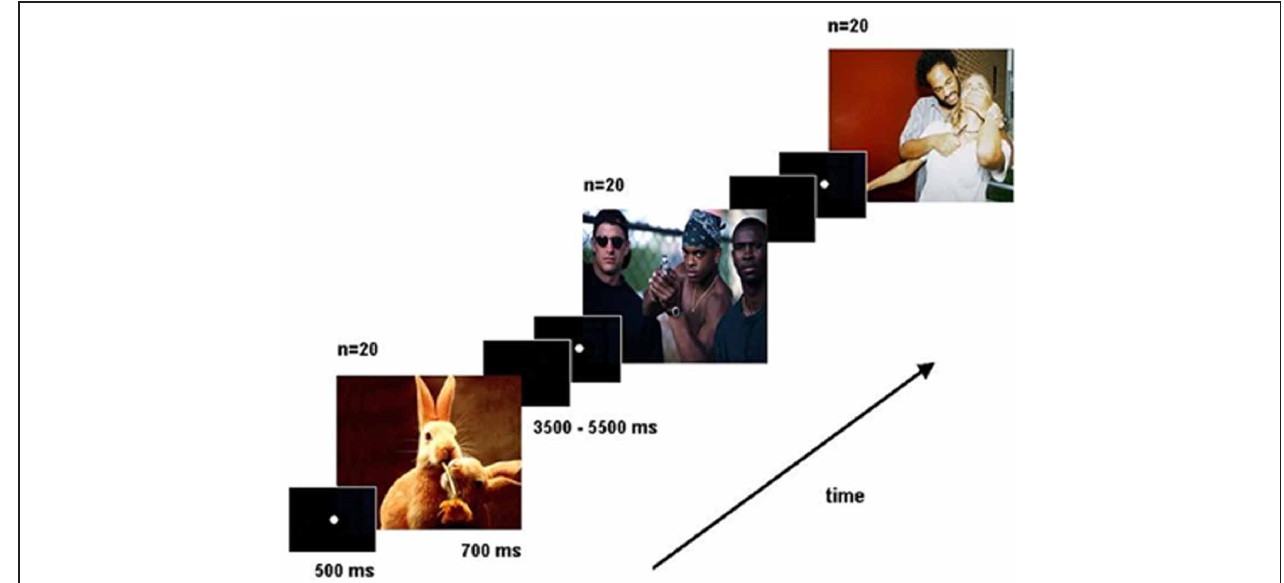
FIGURE 1 | Schematic of the Emotional Reactivity